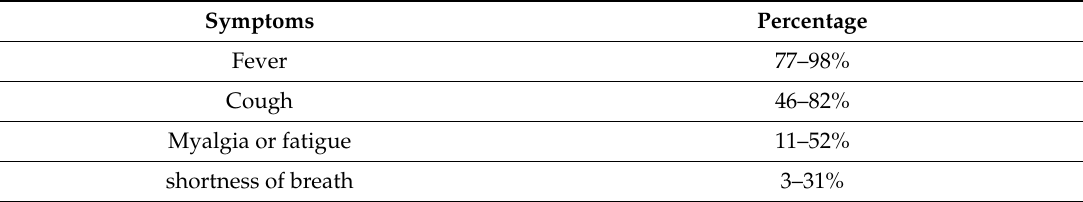
Table 5. COVID-19 patient’s reported symptoms